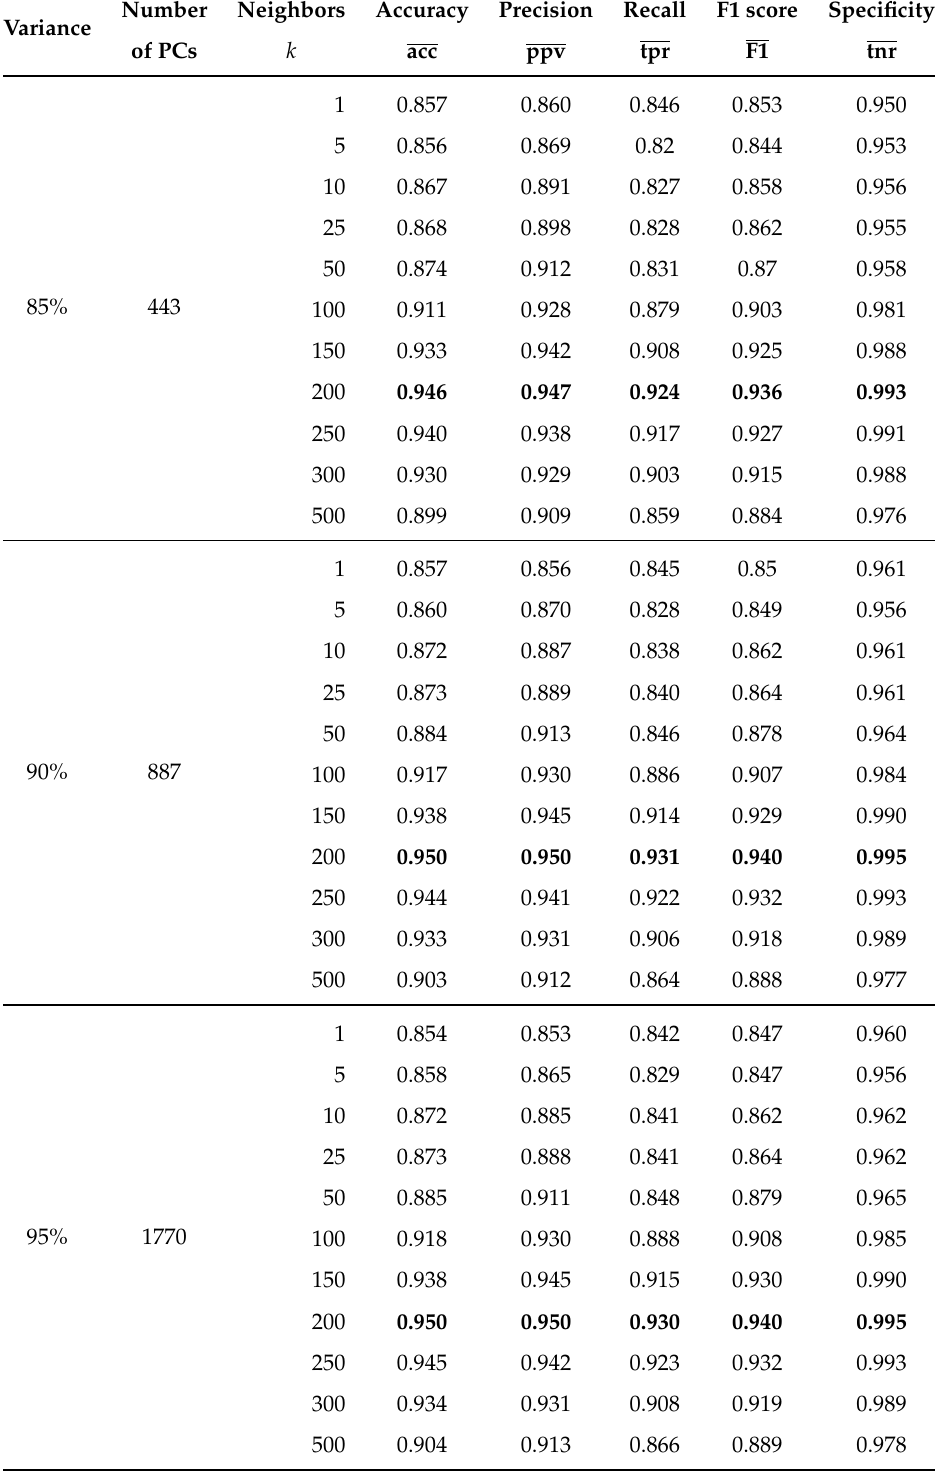
Table 5. Evaluation indicators for the k -NN method using different percentages of variance and different number of nearest neighbors ( k ). The best classifiers for each variance are highlighted using a boldface